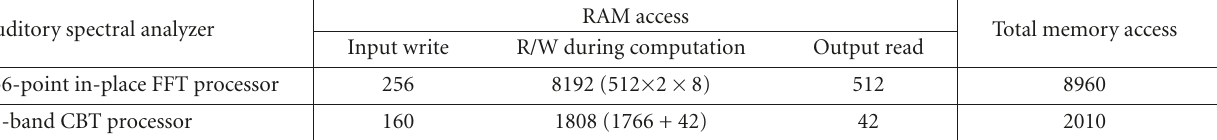
Table 4: Comparison of on-chip memory